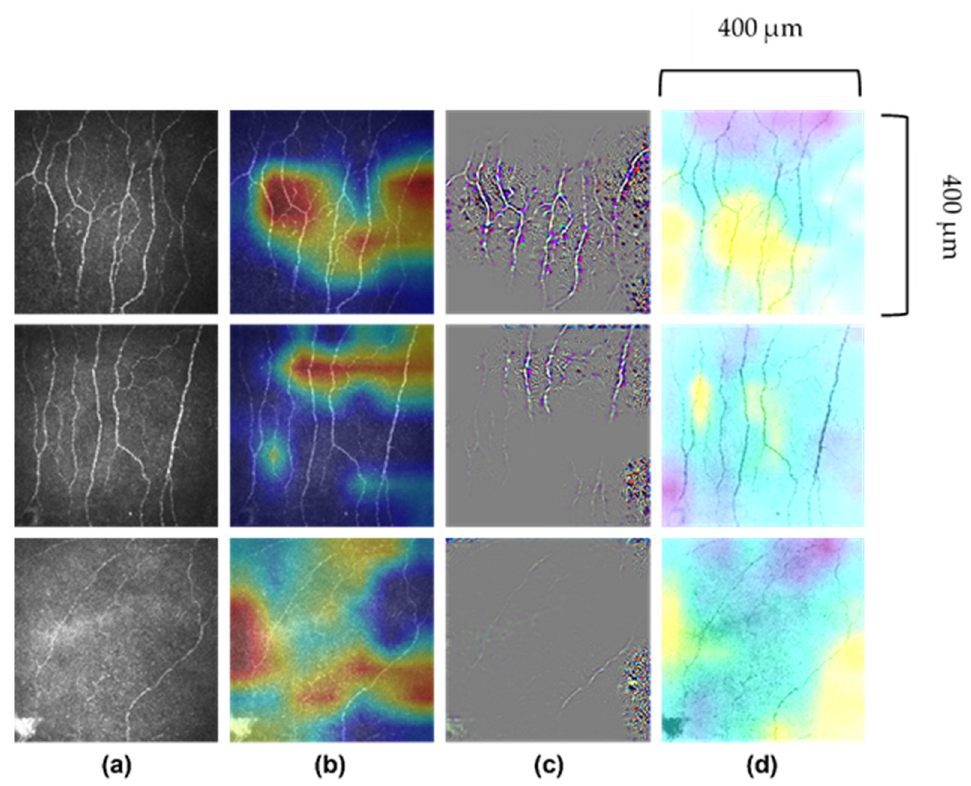
Figure 3. Images of corneal nerves and their respective analysis by AI. ( a ) Original images. ( b ) Attribution map generated by Grad ‐ CAM (gradient ‐ weighted ‐ class activation mapping). ( c ) Attribution map generated by Guided Grad ‐ CAM. ( d ) Attribution map generated by Occlusion Sensitivity. First row correctly predicted healthy volunteer participant; second row, correctly predicted participant with diabetes or prediabetes without neuropathy and third row, correctly predicted participant with diabetes or prediabetes with neuropathy. Images 400 μ m × 400 μ m.